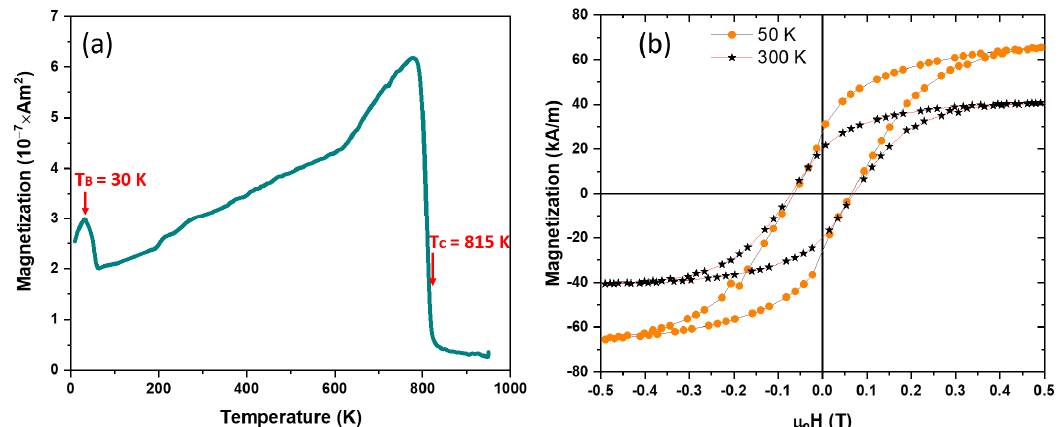
Figure 5. Magnetic properties of the annealed NPs: ( a ) M vs. T data of the annealed NPs; and ( b ) hysteresis loops of the annealed NPs at 300 and 50 K.